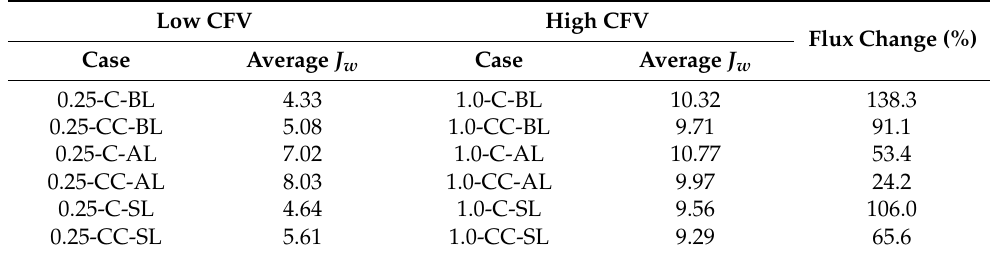
Table 5. Average water flux (L/m 2 · h) at low and high CFV for the cases with MgCl 2 draw solution.